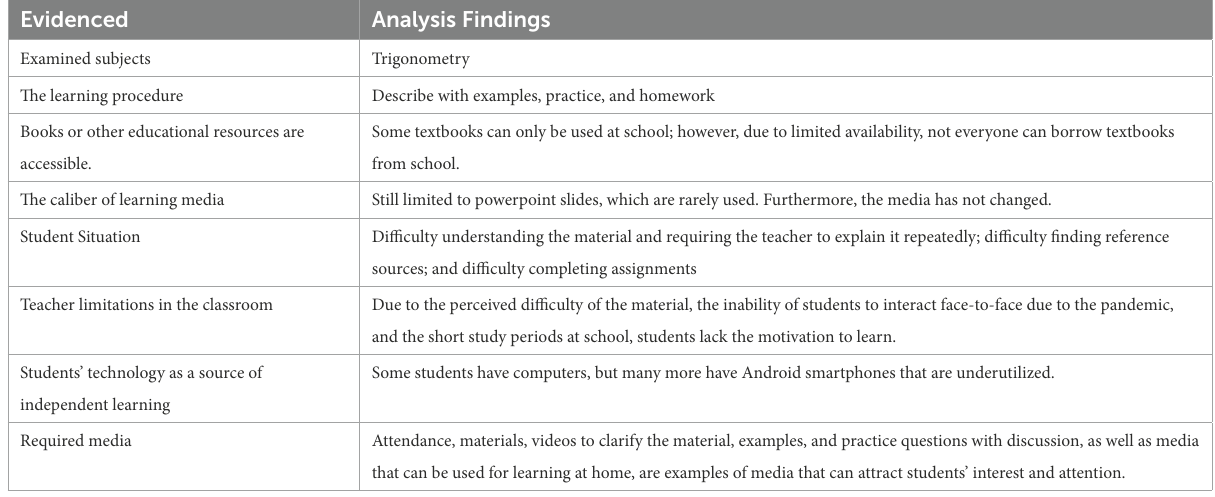
TABLE 3 Observational and interview-based data.